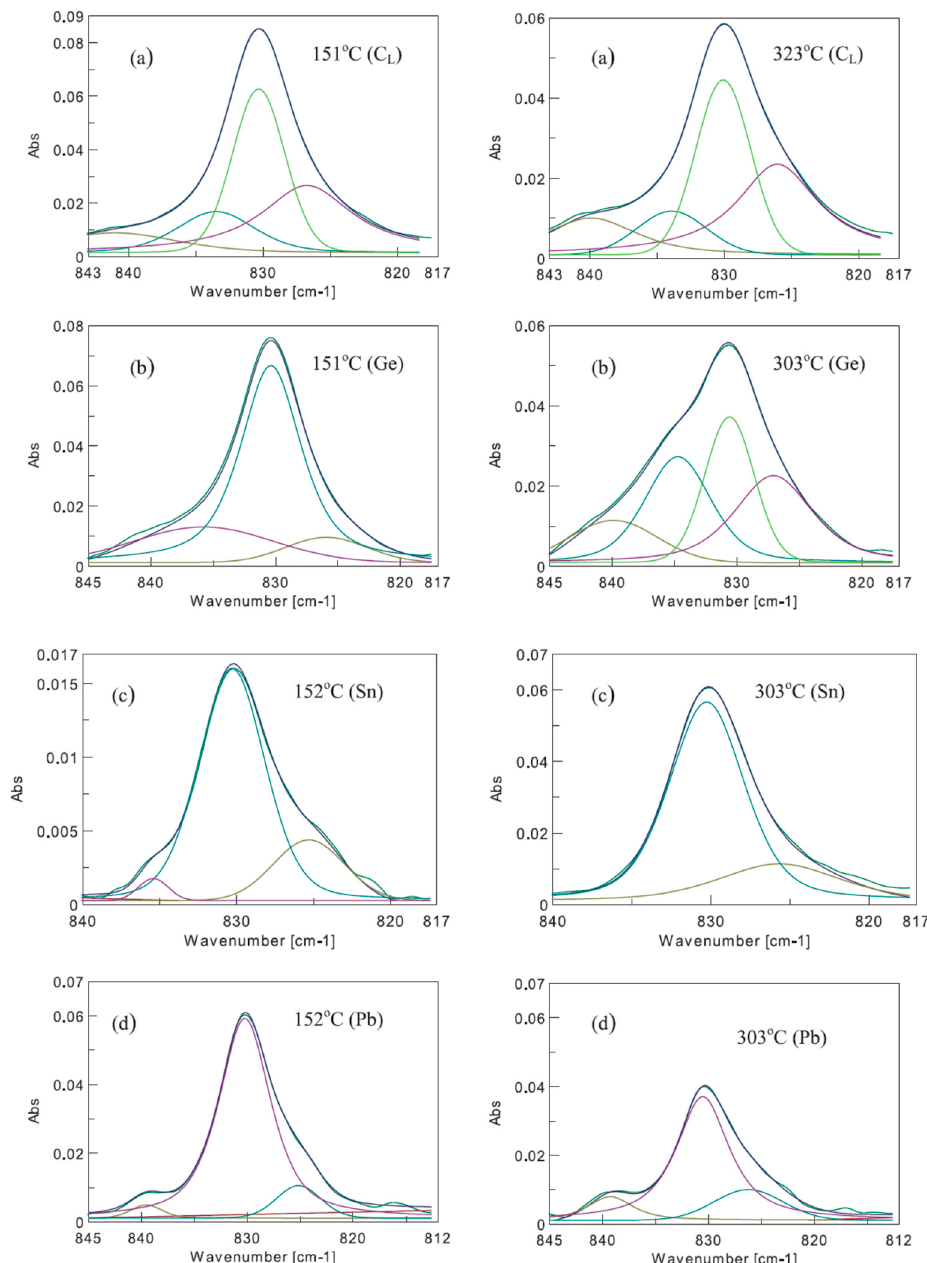
Figure 11. Deconvolution of the VO defect spectral region of the IR bands into Lorentzian profiles for the samples (C L ) ( a ), (Ge) ( b ), (Sn) ( c ), and (Pb) ( d ). Reproduced with permission from [143]. American Institute of Physics, 2012.